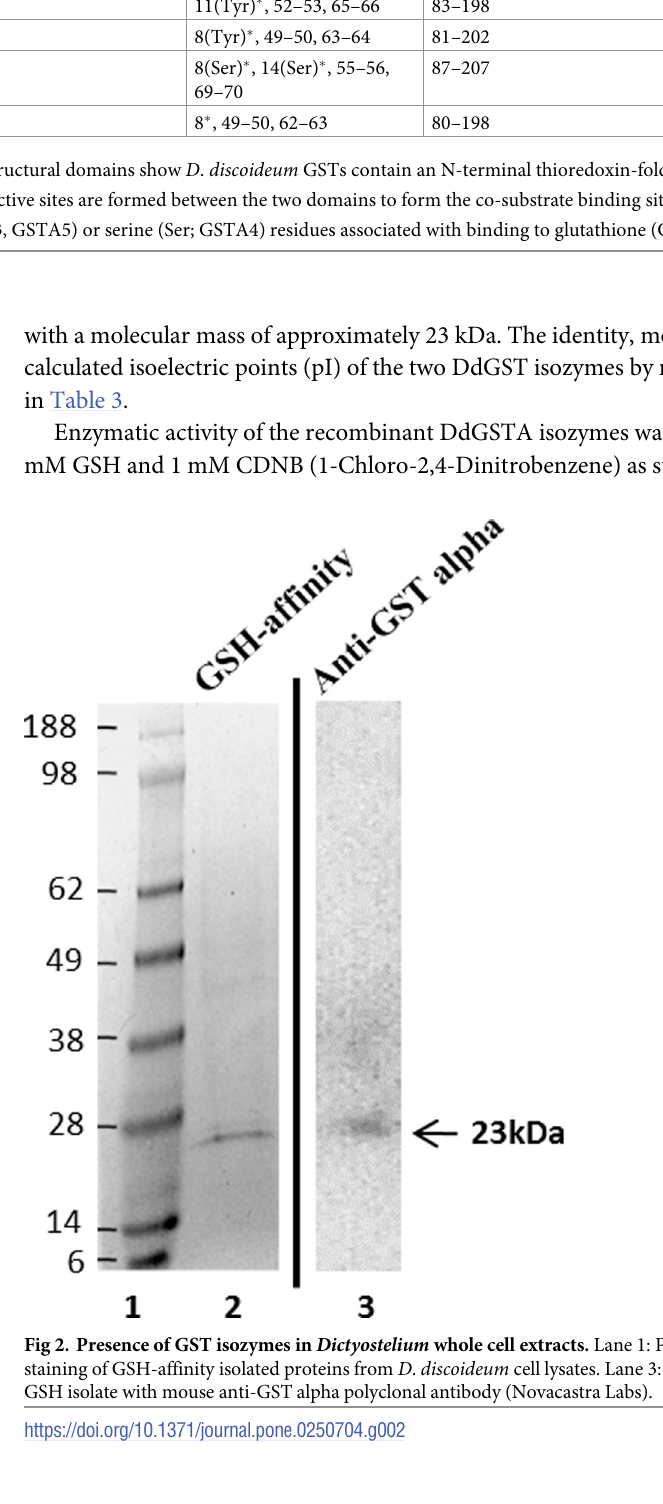
Fig 2. Presence of GST isozymes in Dictyostelium whole cell extracts. Lane 1: Protein marker. Lane 2: Coomassie staining of GSH-affinity isolated proteins from D . discoideum cell lysates. Lane 3: anti-GST alpha immunoblotting of GSH isolate with mouse anti-GST alpha polyclonal antibody (Novacastra